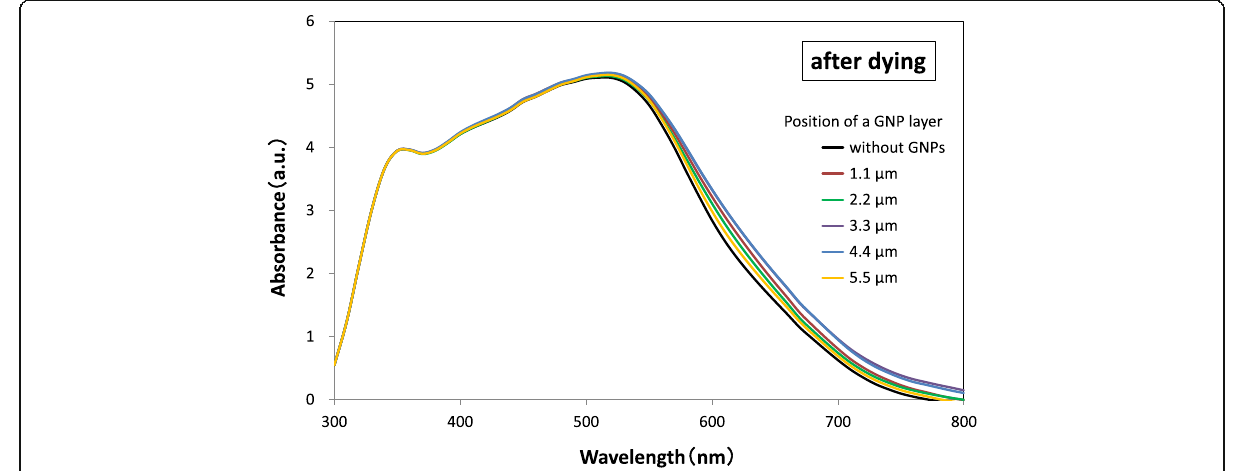
Fig. 7 Absorbance spectra of TiO 2 layers with varying the position of a GNP layer. The density of GNPs is 2.7 μ g/cm 2